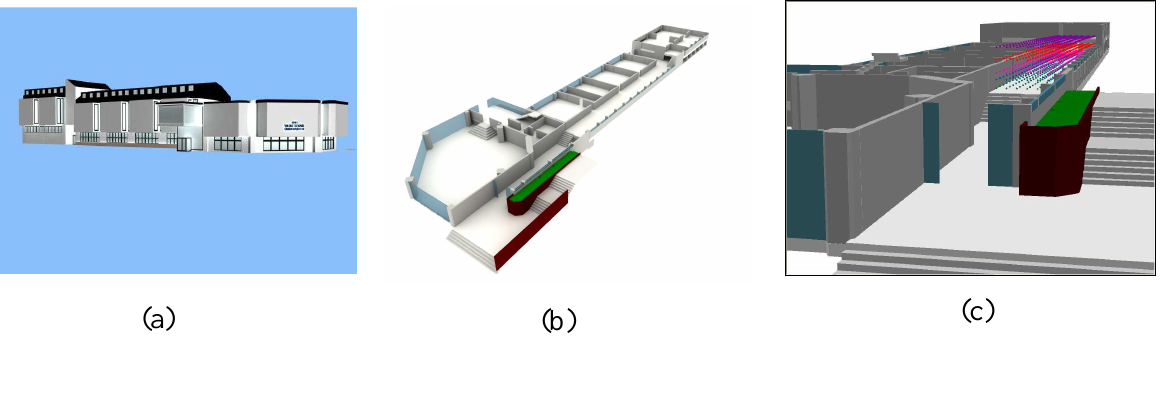
Figure 5. (a) T-Block building. (b) T-Block entrance floor. (c) Observation points along the corridor at 5 different height levels.